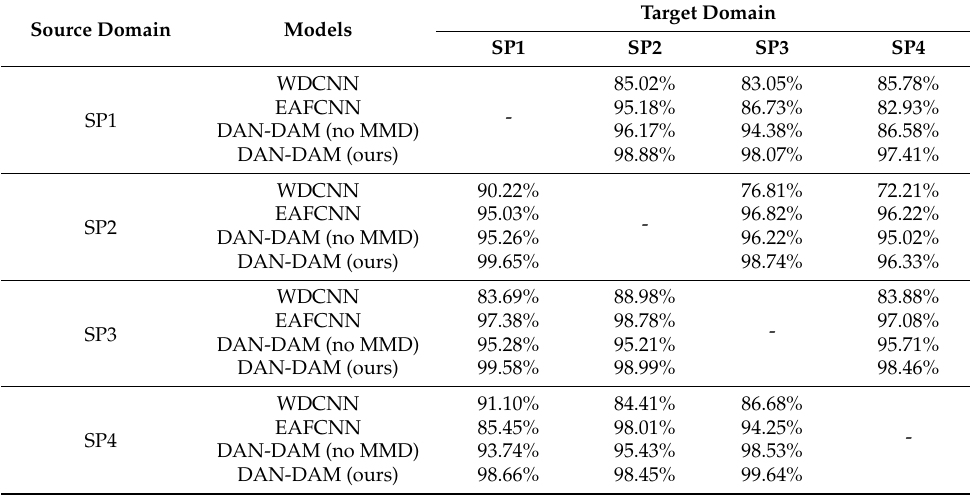
Table 3. Various transfer results of four